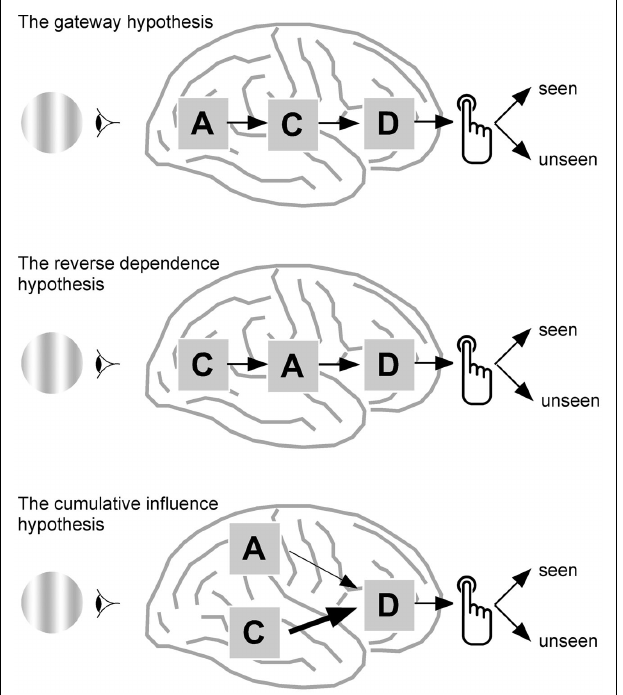
FIGURE 1 | How attention and consciousness could be related. Three options are presented, that all depend on attention-related activities, noted as A, consciousness-related activity, noted as C, and decisional process, noted as D, until the subject finally produces his or her behavioral report on the presence or absence of a stimulus.Top, the gateway hypothesis. In this classical view (Dehaene et al., 2006), attention facilitates consciousness, and could even be considered as necessary for consciousness to emerge. Middle, the reverse dependence hypothesis. Alternatively, whether a stimulus has been detected or not at the neural level could trigger different attentional mechanisms. Although some behavioral data could be in line with this possibility (Hsu et al., 2011), it is not directly supported by neural data so far. Bottom, the cumulative influence hypothesis. In this view, that could account for a number of imaging results, attention, and consciousness would be implemented by distinct neural mechanisms, but would both influence, although with different weights, the final report of the subject on the presence or absence of a stimulus.This hypothesis postulates the existence of a decision variable that would accumulate mainly consciousness-related neural activity, but also, to a lesser extent, attention-related neural activity. Behavioral reports based on this decision variable could therefore show an interaction between attention and consciousness, whereas neural variables could be related solely to attention and